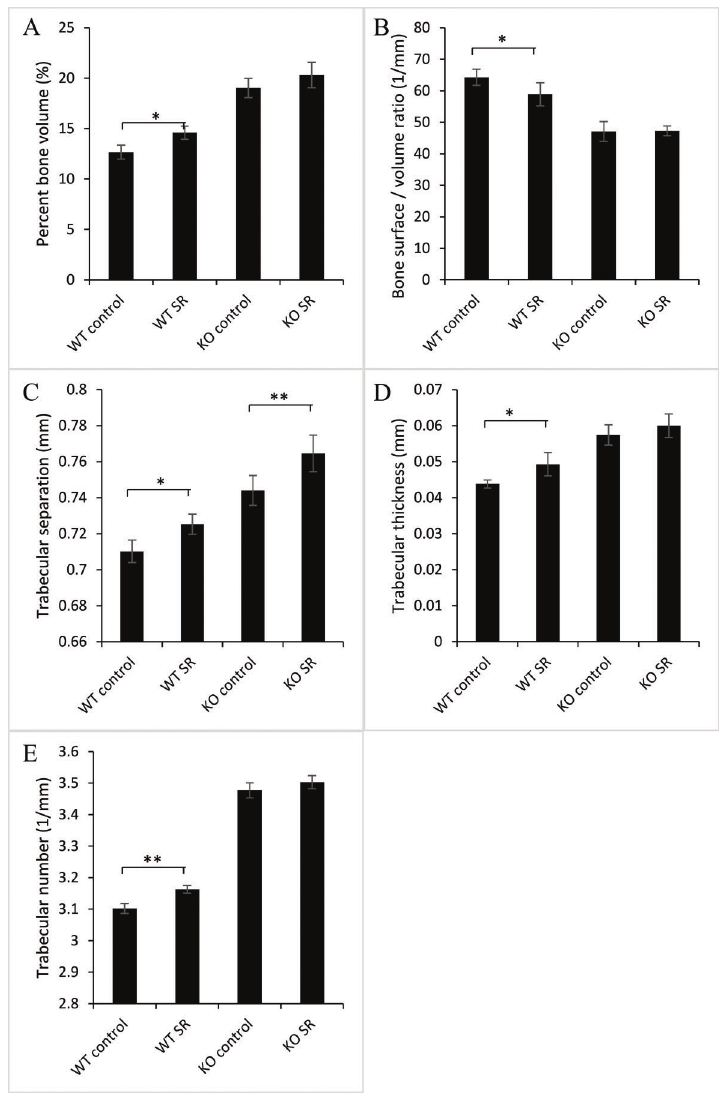
Figure 3. Micro-computed tomography analysis of bone microstructure. A , percent bone volume; B , bone surface/volume ratio; C , trabecular sepa- ration; D , trabecular thickness; E , trabecular number. Data are reported as means ± SD. *P o 0.05, **P o 0.01 (ANOVA). SR: strontium ranelate; WT: wild type; KO: